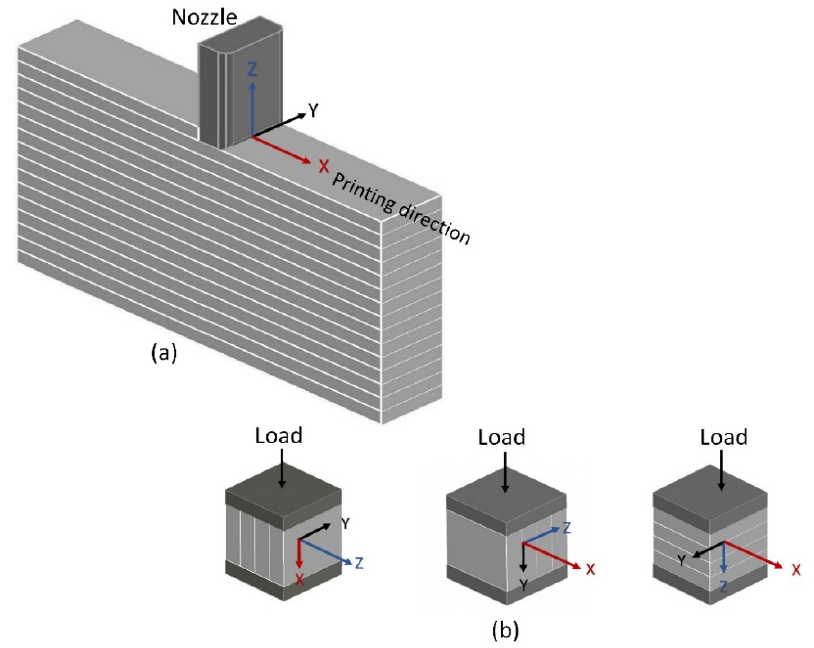
Figure 6. ( a ) Designation of directions X , Y , and Z axes, to evaluate the anisotropic mechanical be- Materials 2021 , 14 , x FOR PEER REVIEW havior; ( b ) measurement of anisotropy in compressive strength. behavior; ( b ) measurement of anisotropy in compressive strength.